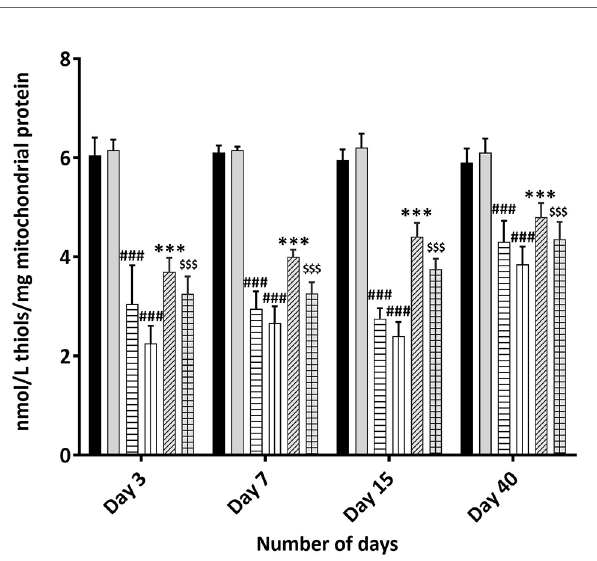
FIGURE 8 | Total Thiol estimation using Ellman ’ s reagent: Mice were treated with MOS (200 mg/kg bw) and/or subjected TBI (3 and 5 Gy) and assessed for total thiol levels in mice kidney mitochondria as described in Materials and Methods . Error bars represent mean ± SD, ### p < 0.001 were considered signi fi cant compared to un-irradiated control group, *** p < 0.001 were considered signi fi cant compared to irradiated group and $$$ p < 0.001 were considered signi fi cant compared to 5 Gy irradiated group.